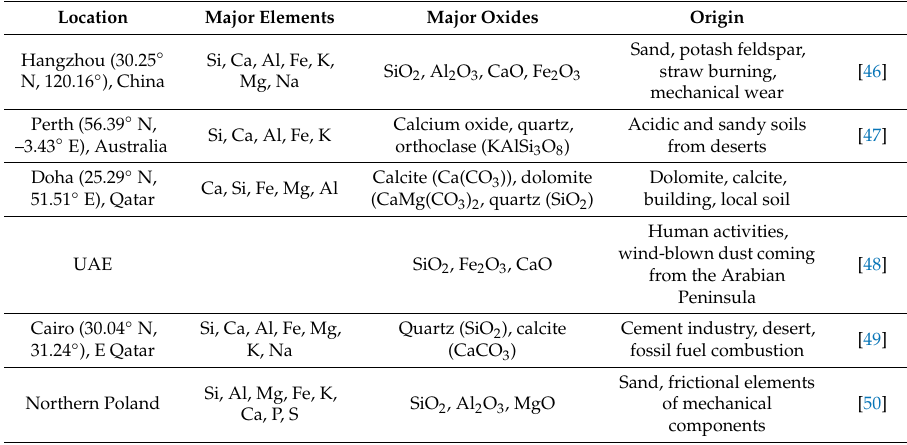
Table 1. Comparison of dust samples in some places